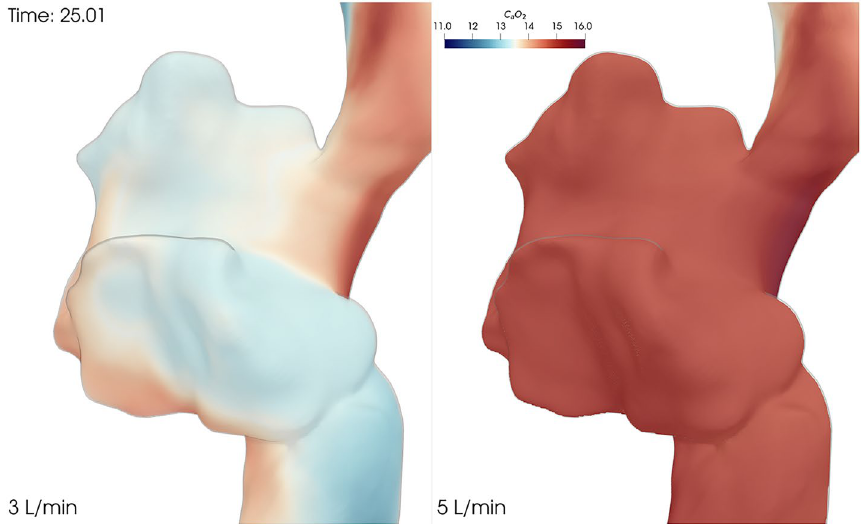
Figure 5. Volumetric representation of the oxygen content. Oxygen content ( C a O 2 ) in the right atrium for the 3 L/min (left) and 5 L / min (right) cases after 25 s of simulation. This plot shows how an ECMO flow of 3 L/min, despite minimising recirculation, does not carry enough oxygen to adequately oxygenate the blood in the right atrium. With an ECMO flow of 5L / min , on the other hand, a larger amount of oxygen accumulates in the right atrium, despite the increased recirculation stemming from a higher flow. Additional file 3 contains a video that clearly shows this phenomenon.